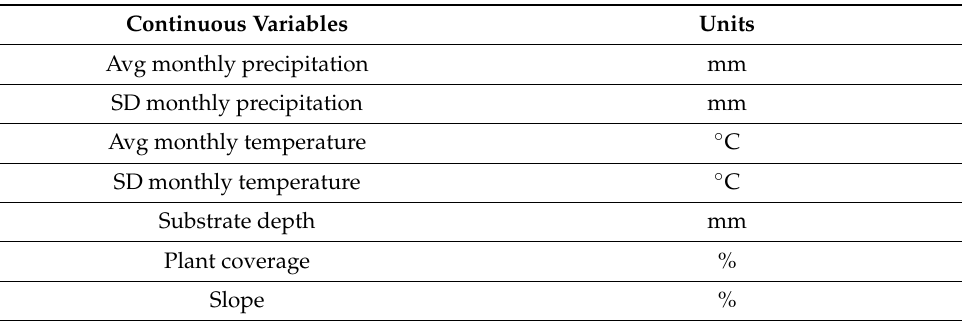
Table 3. Continuous variables under study and corresponding